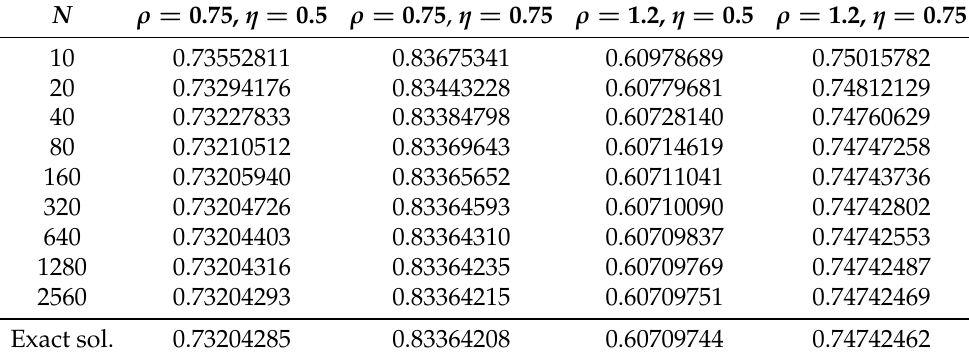
Table 1. Numerical solutions to the IVP (54) when α = 0.9 at t = 0.5.